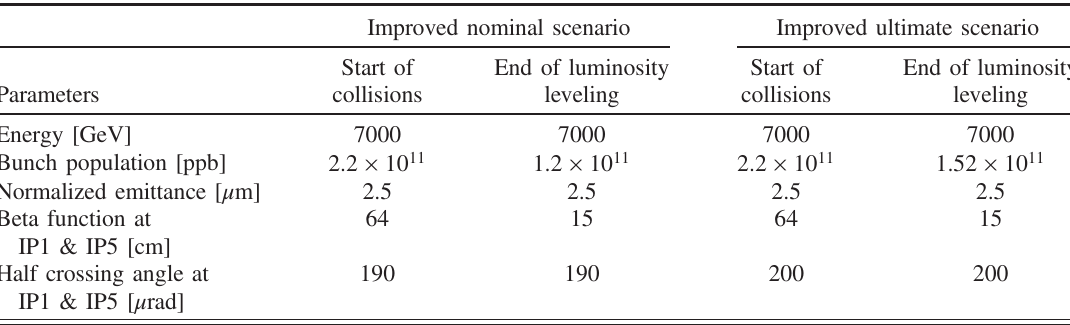
TABLE II. HL-LHC improved scenarios at the start of collisions and the end of the luminosity